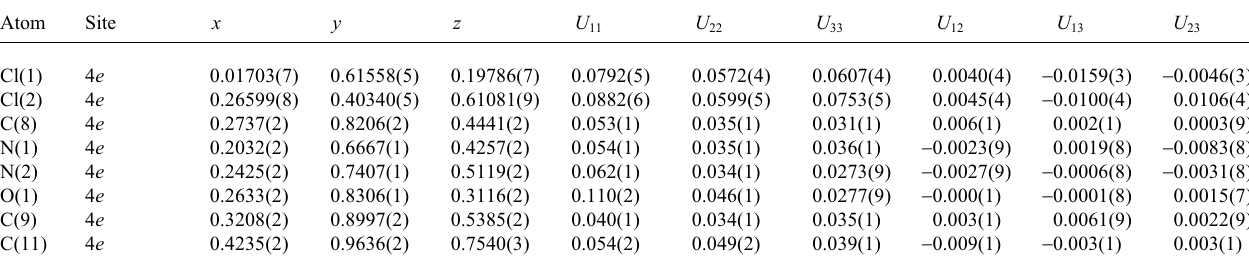
Table 3. Atomic coordinates and displacement parameters (in Å 2